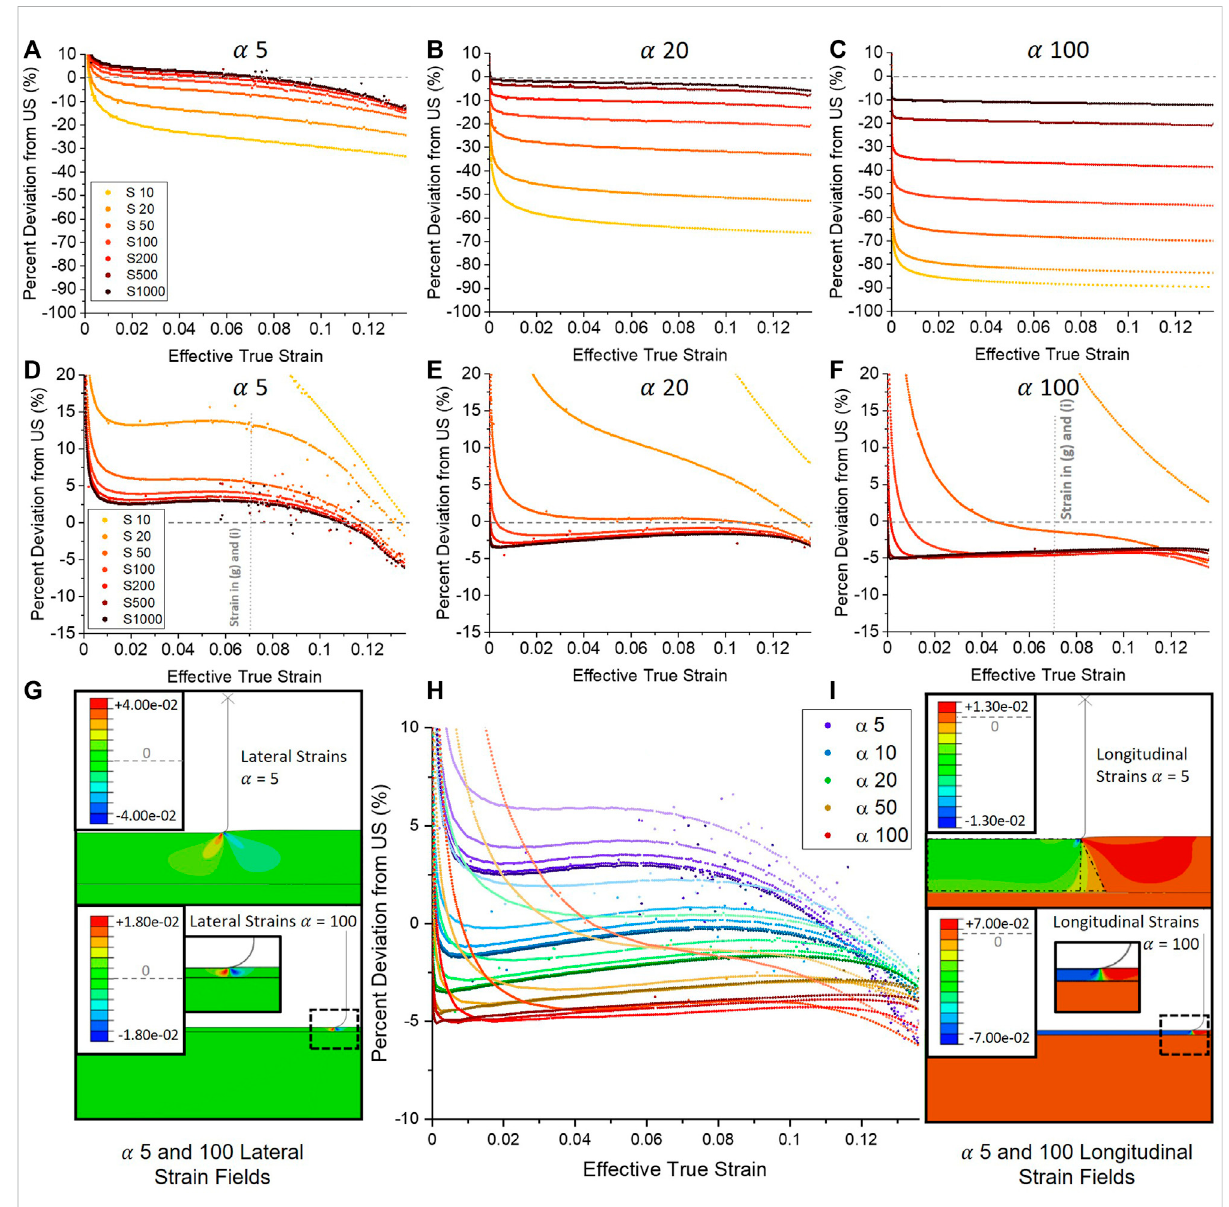
FIGURE 4 Results of Figures 2A,B re-expressed as deviation of LCT Mean Stress vs. Effective true strain relative to pure uniaxial strain up until yield strain without (A – C) and with (D – F) the substrate stiffness correction. The gradual downwards slope with strain present in all datasets is due elastic relaxation of the con fi ning fi lm [visualised in (G) ], introducing non – uniaxial deformations into the fi lm. An analytical substrate correction step as per Eqs.9,10canreducethiserrortothoseshownin (D – F) .Asdiscussedearlier,thissimplesubstratecorrectiongrosslyover-compensatesatlow S asdescribedforFigure2F – H , butcanotherwisereducetheerrorfromUStolessthan±5%.Thefullcorrecteddatasetiscompiled in (H) for allaspect ratios, excluding S = 10 and 20 for clarity. Competing error effects can actually allow lower aspect ratio indentation (which is in a pure sense further fromUS)toachievebetter fi delitytotheUScondition.Deviationsfromuniformstrainofthepuckunderthepunchcanbeanalysed via thestrain fi elds extracted from the fi nite element simulations. Shown are lateral strains of imperfect con fi nement by the surrounding fi lms visualized in (G) and spreadingofnormalstressthroughthe fi nite fi lmthicknessfromthepunchcontactzonetothesubstratebelowvisualizedin (I) asgradientsinvertical strain spreading with depth in the fi lm beyond the punch